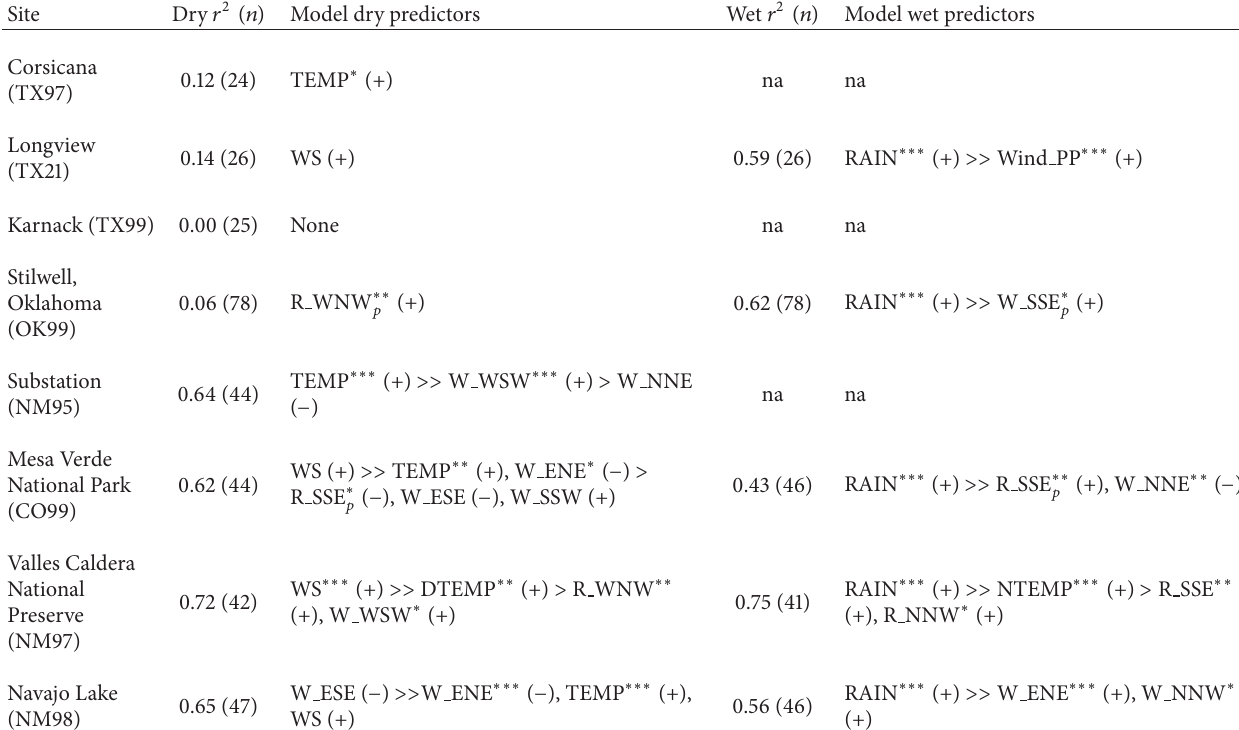
Table 3: Regression results: coefficients of determination (𝑟 2 ) and sample size (𝑛) for meteorological data modeling for Texas, Oklahoma, and Four Corners area sites.